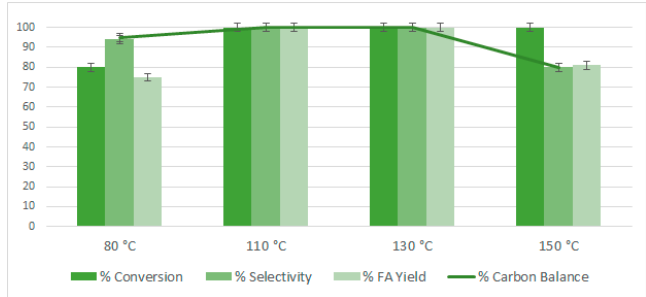
Figure 8. Effect of the reaction temperature using Au/HT 4:1. Furfural oxidation, batch reactor, p = 6 Figure 8. E ff ect of the reaction temperature using Au / HT 4:1. Furfural oxidation, batch reactor, p = 6 bar (O 2 ), 600 rpm, 2 h, FF/Au = 80, [FF] = 26 mM, 63 mg of catalyst. bar (O 2 ), 600 rpm, 2 h, FF / Au = 80, [FF] = 26 mM, 63 mg of